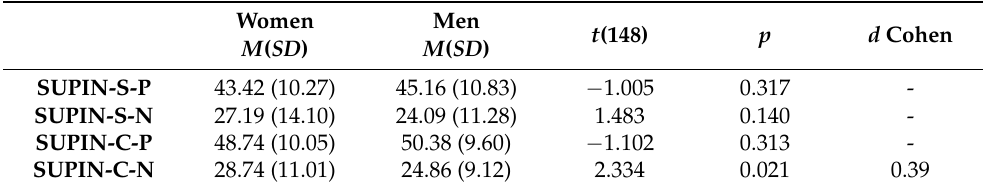
Table 6. The differences between women and men in terms of intensity of positive and negative emotions.